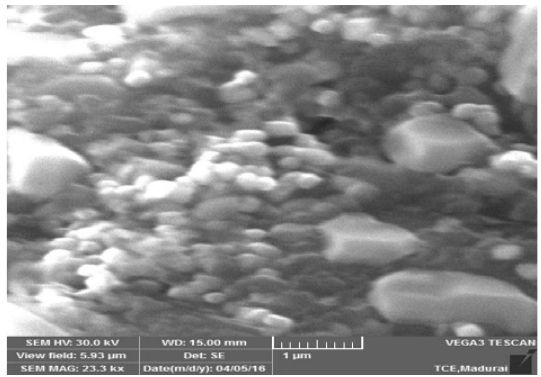
Fig. 4. SEM image of Bi Fig 4.